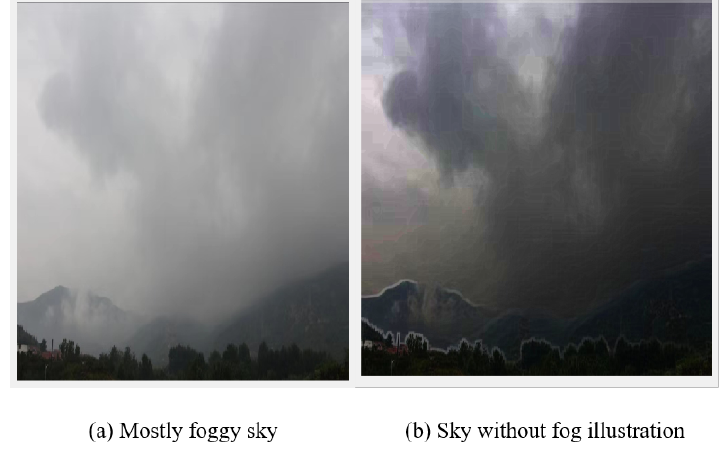
Figure 2. Comparisons of dark channel failure